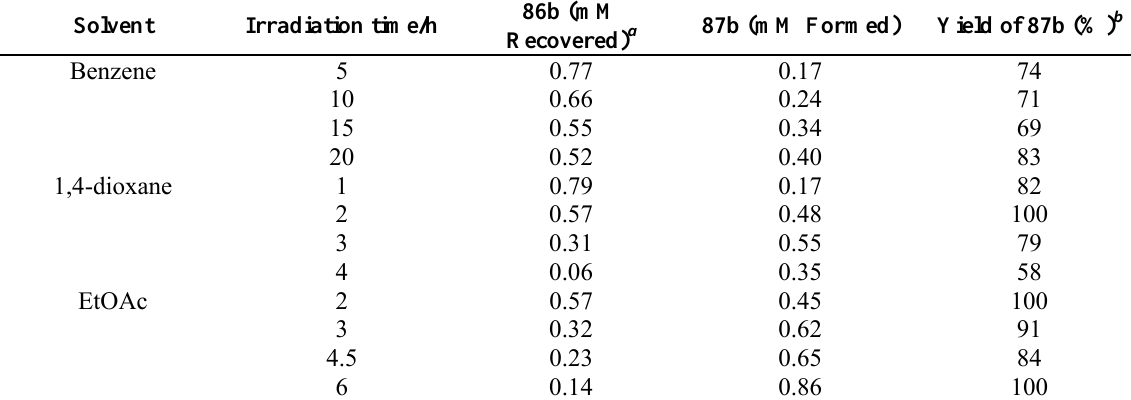
Table 9. Effect of irradiation time on the yield of photochemical flavanone 87b formation from